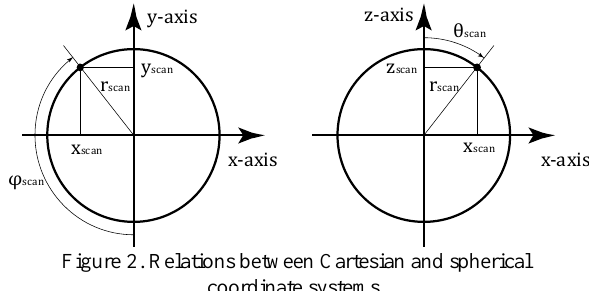
Figure 2. Relations between Cartesian and spherical coordinate systems.